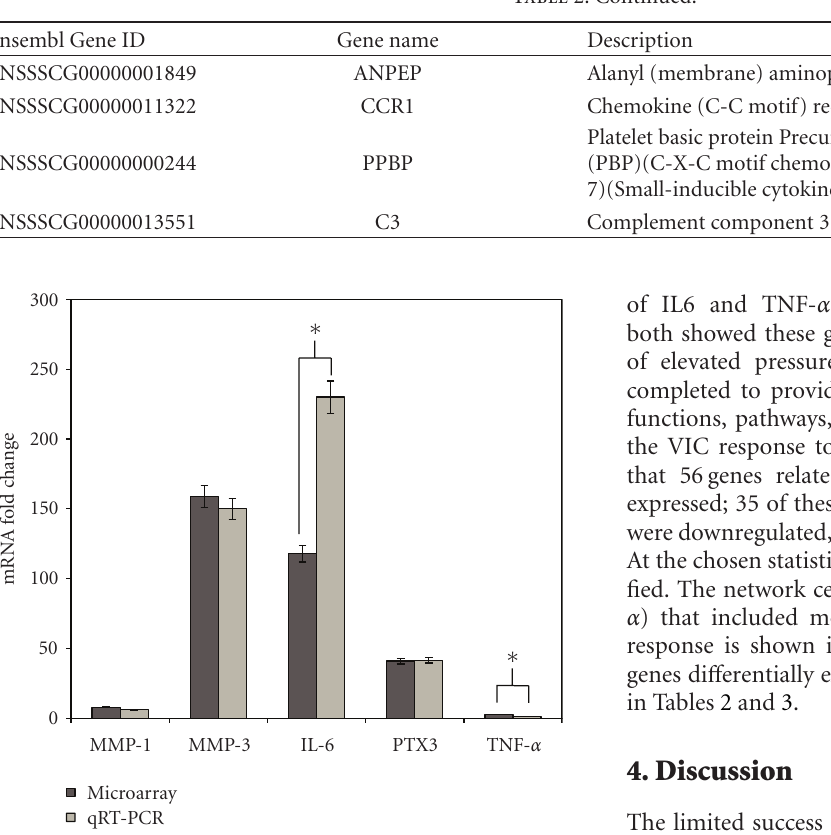
Figure 4: Confirmation of microarray data by real-time qRT-PCR. The fold change in gene expression was significantly higher in VICs exposed to elevated pressure compared to VICs exposed to normal cyclic pressure. ∗ Represents a significant di ff erence between microarray and qRT-PCR